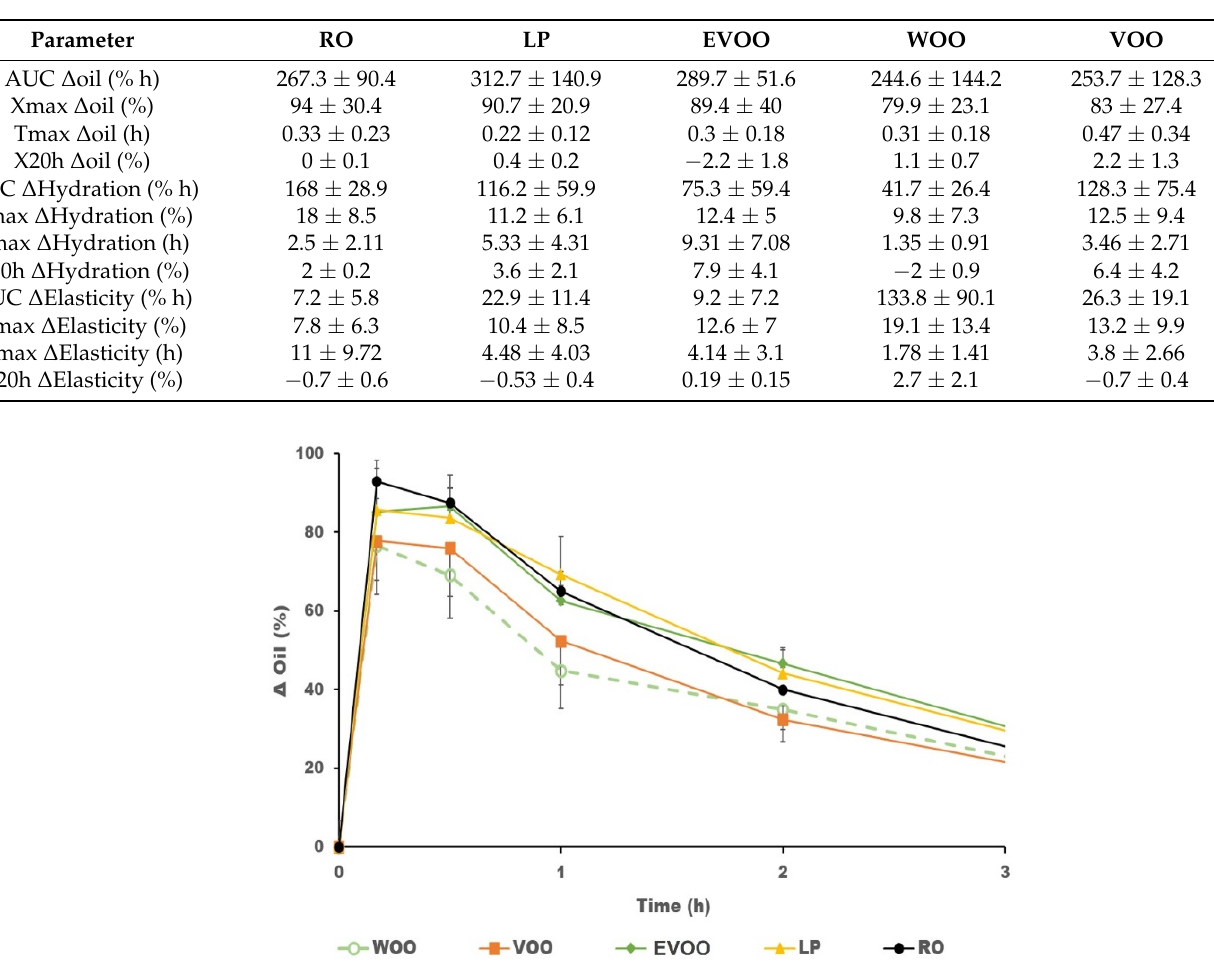
Figure 2. Mean results and variability ( n = 8) in the increase in oil (%) at the site of administration during the first 3 h after application.